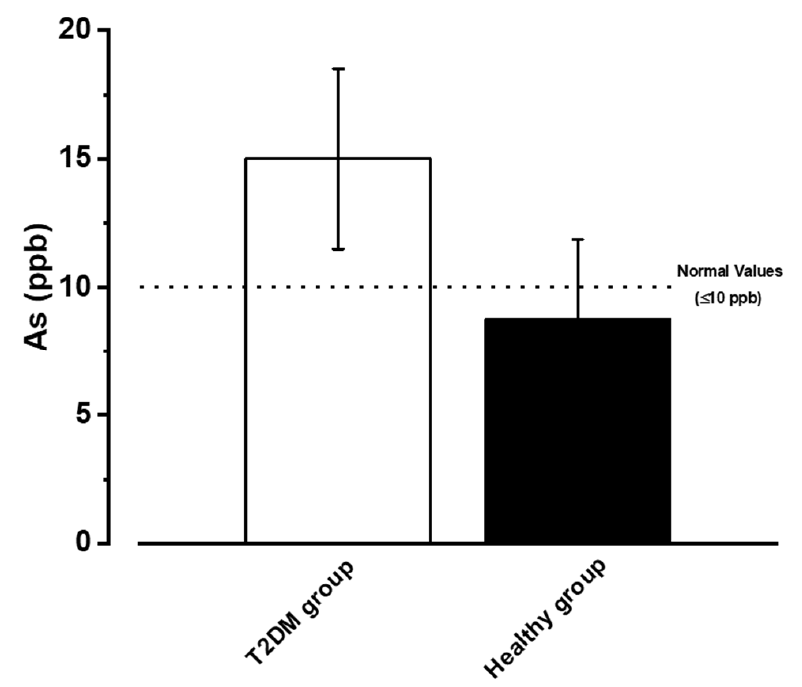
Figure 1. Urinary As levels in the participating groups, the graph represents the X ± E.E. of the urinary As concentration (ppb), * p ≤ 0.05 ( t ‐ Student). The pharmacokinetics of pioglitazone was analyzed at a dose of 30 mg p.o. This